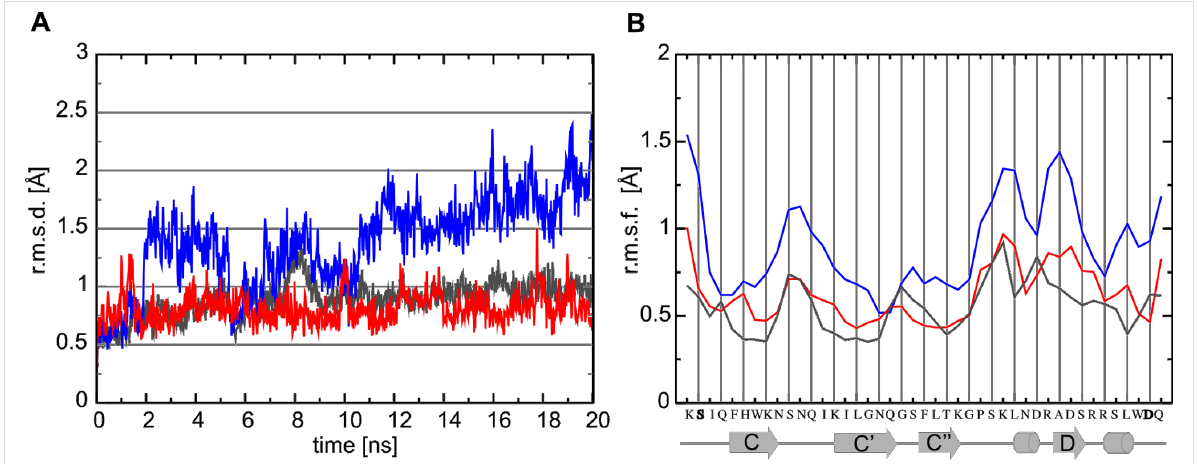
Figure 5: Conformational stability of CD4 mimetic peptides in complex with gp120 during 20 ns of MD simulation. Results are shown in blue (CD4- M1) and red (CD4-M2), respectively. For comparison, the respective sequence region has also been analysed for the CD4–gp120 complex (black). (A) Root-mean-square deviation of the peptides and CD4 over simulation time. (B) Root-mean-square fluctuation of individual residues measured for backbone atoms averaged over time. Residues replaced by cysteine in CD4-M2 are indicated in bold face. Secondary structure elements are assigned below the plot.